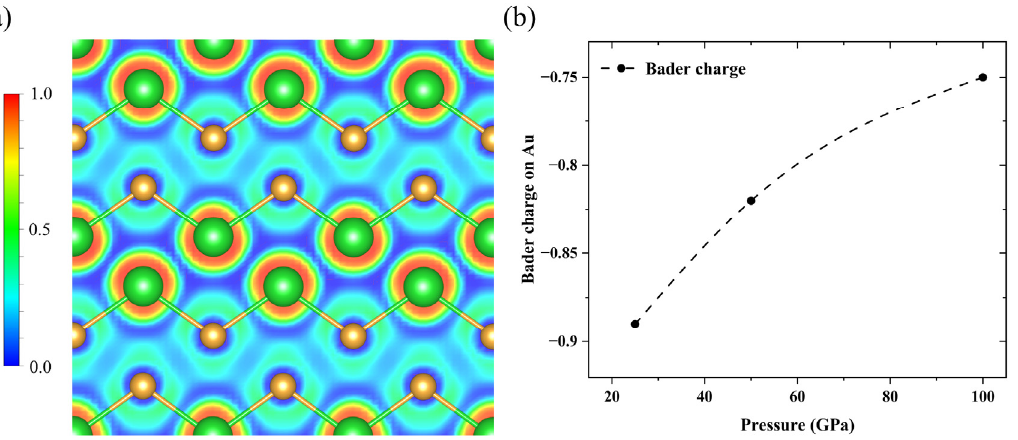
Figure 4. ( a ) Calculated electron localization function (ELF) for Fd -3 m -BaAu compounds on the (101) plane at 25 GPa. ( b ) Pressure dependence of the Bader charges on Au in Fd -3 m- structured BaAu from 25 to 100 GPa.